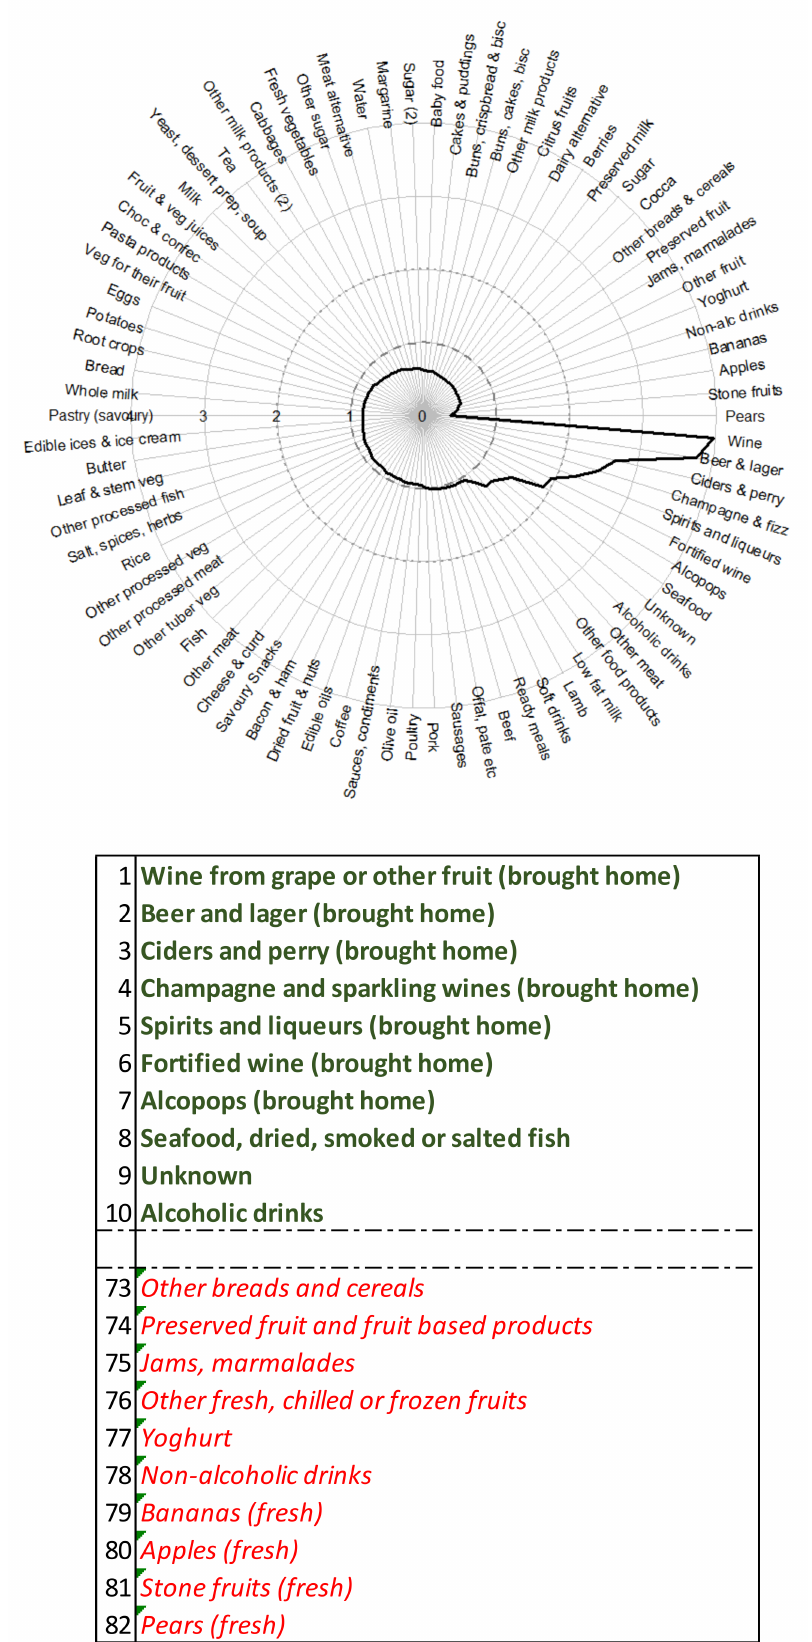
Figure A6. Beer and wine lovers ( n =